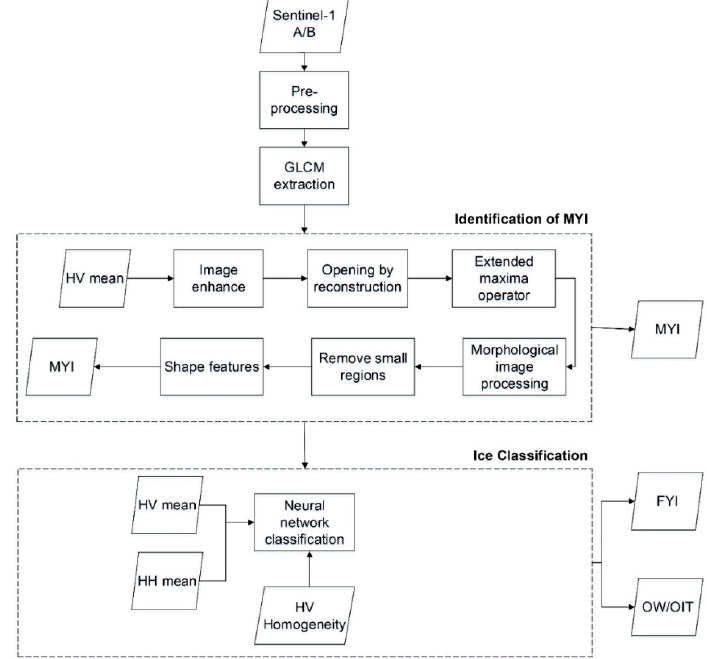
Figure 2. Flow chart of the TEMS-N method. Only mean texture parameter from the 𝜎 (cid:3035)(cid:3049)(cid:3042) image is used in Identification of MYI while mean texture from 𝜎 (cid:3035)(cid:3035)(cid:3042) , mean from the 𝜎 (cid:3035)(cid:3049)(cid:3042) and homogeneity texture from 𝜎 (cid:3035)(cid:3049)(cid:3042) are used in neural network classification.